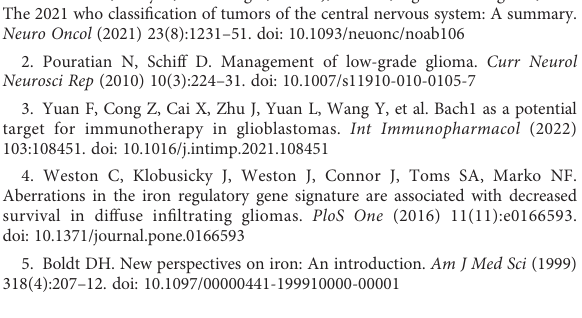
(B) Relationships between hepcidin expression and different clinical features. *** p < 0.001. SUPPLEMENTARY FIGURE 2 Cox regression analysis and establishment of the prognostic model using TCGA dataset. (A) The univariate analysis of hepcidin expression in TCGA dataset. (B) The multivariate analysis of hepcidin expression in TCGA dataset. (C) The nomogram was constructed based on four factors for predicting 1- year, 3-year or 5-year survival of patients with glioma in TCGA. (D) The calibration plots of internal validation in TCGA dataset showed good consistency in predicting 1-year, 3-year or 5-year survival. (E) The 1-year, 3- year and 5-year ROC curves for TCGA dataset. **p < 0.01 and ***p < 0.001. SUPPLEMENTARY FIGURE 3 Functional analysis of DEGs between high and low hepcidin expression groups using TCGA dataset. (A) Heatmaps of the DEGs between hepcidin high and low expression groups. (B, C) The GO and KEGG analyses of DEGs. (D, E) GSEA of GO (D) and KEGG (E) analyses of hepcidin high and low expression groups in TCGA dataset. SUPPLEMENTARY FIGURE 4 Analysis of immune cell in fi ltration with the CIBERSORT algorithm in TCGA database. (A) The abundance ratios of immune cells in TCGA samples. The 22 speci fi c immune cells that corresponded to one sample are indicated with different colors in the bar plot. (B) The correlation analysis of cells in TCGA database. (C) The changes in the proportions of 22 subtypes of immune cells in high and low hepcidin expression groups of tumor samples. Horizontal and vertical axes represent TIICs and relative percentages, respectively. Blue and red colors represent low and high hepcidin expression groups, respectively. SUPPLEMENTARY FIGURE 5 Hepcidin expression in different cells was analyzed in GSE84465, GSE89567, GSE131928, GSE148842 and GSE138794 datasets using the TISCH database. SUPPLEMENTARY FIGURE 6 The correlations between hepcidin and expression of macrophage markers based on the TCGA database. (A) Scatterplots of the correlations between hepcidin expression and CD163, CD68, MARCO, MRC1, MSR1 and FCGR3A expression in GBM. (B) Scatterplots of the correlations between hepcidin expression and CD163, CD68, MARCO, MRC1, MSR1 and FCGR3A expression in LGG. SUPPLEMENTARY FIGURE 7 The effect of hepcidin expression on temozolomide sensitivity. (A) The higher the expression of hepdicin, the lower the IC50 value of temozolomide in brain tumors. (B) Hepcidin expression was negatively correlated with temozolomide sensitivity in brain tumors. ****p <